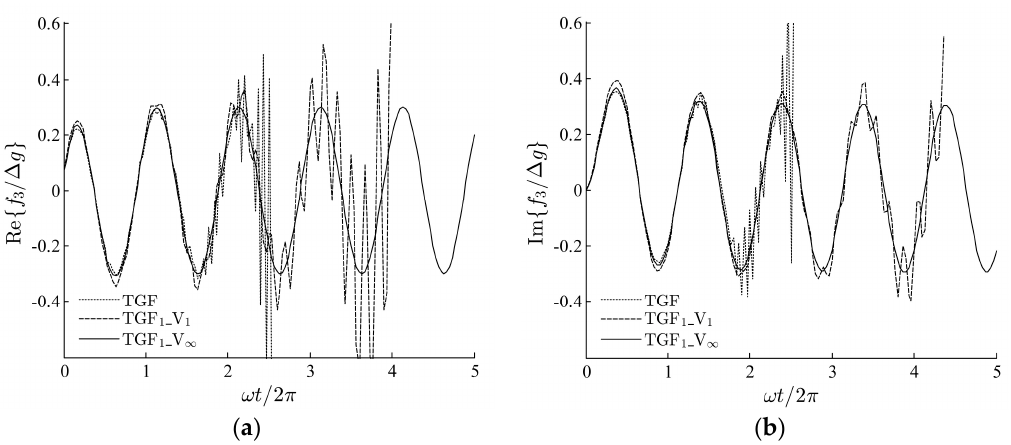
Figure 3. Comparison of time series of heave forces (real and imaginary part) using methods TGF, TGF 1 _V 1 and TGF 1 _V ∞ . The viscous dissipation effects in TGF 1 _V n are considered only at the step of solving source density, after which the viscosity coefficient on all segments is set to zero. ( a ) Real part of heave force; ( b ) Imaginary part of heave force.